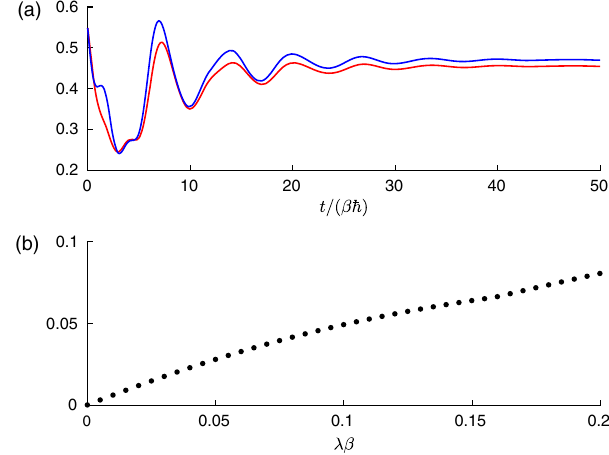
FIG. 17. Approximate fluctuation relation without bound. (a) Analogous to Fig. 16, the functions f ð t Þ (red solid line) and r ð t Þ (blue solid line) are as defined in Eq. (M13) but for the new generator (M14). These are plotted for the interval t= ð β ℏ Þ ∈ ½ 0 ; 50 (cid:2) . (b) The maximum error max r ð t Þj is plotted (filled circles) against the value of λβ